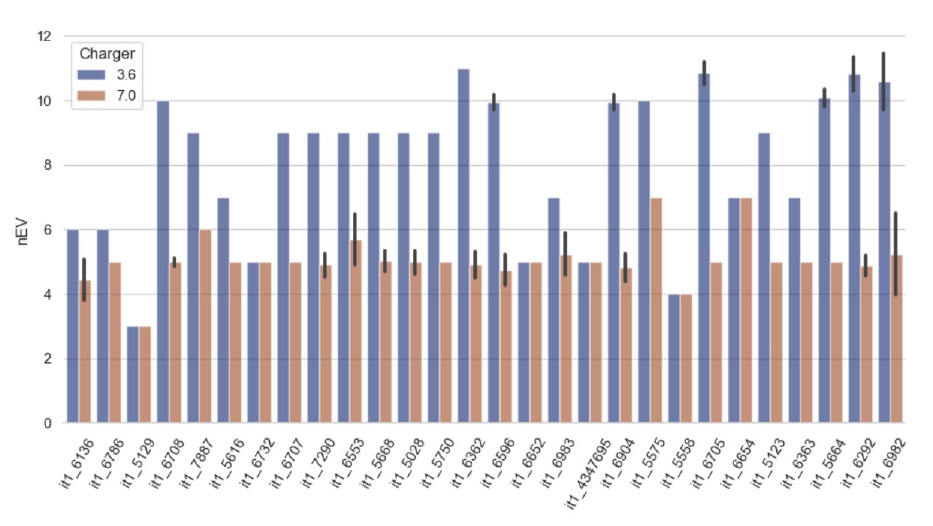
Figure 6. Hosting capacity for 25% of the 45kVA transformers.